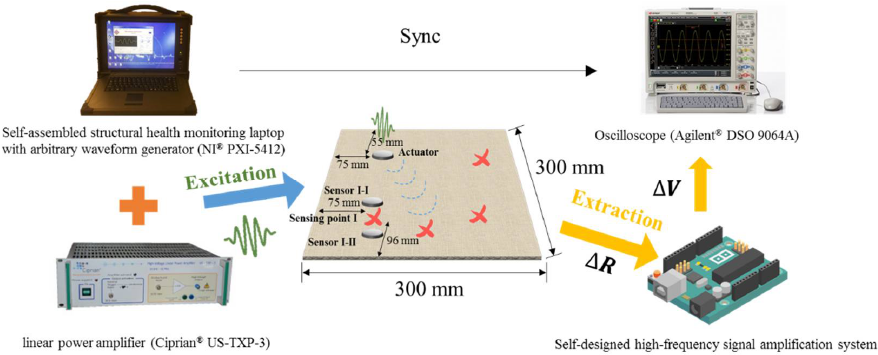
Figure 11. Experimental setup of the excitation and extraction system in the acquisition of UGW test.